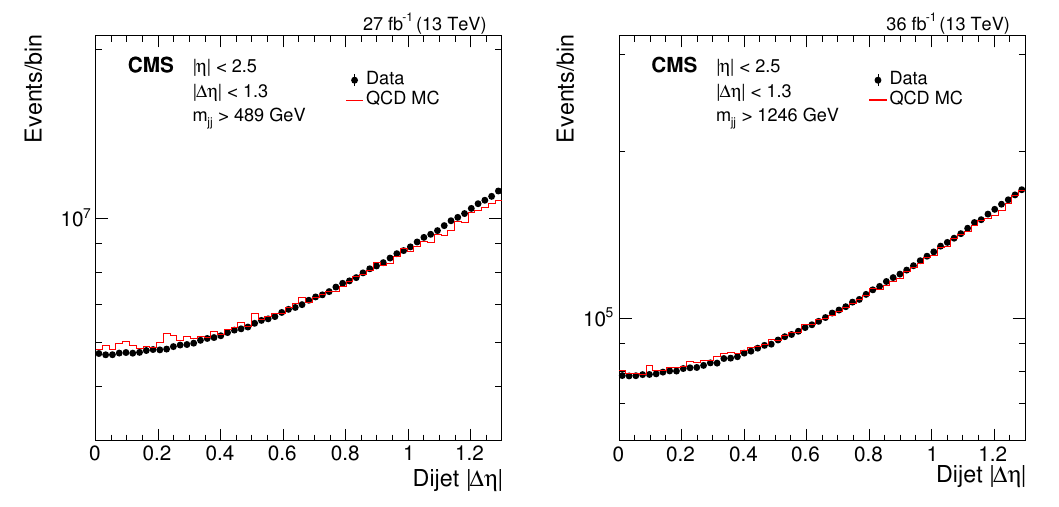
Figure 4 . The pseudorapidity separation between the two wide jets from the low-mass search (left) and the high-mass search (right). Data (points) are compared to QCD predictions from the pythia 8 MC including detector simulation (histogram) normalized to the